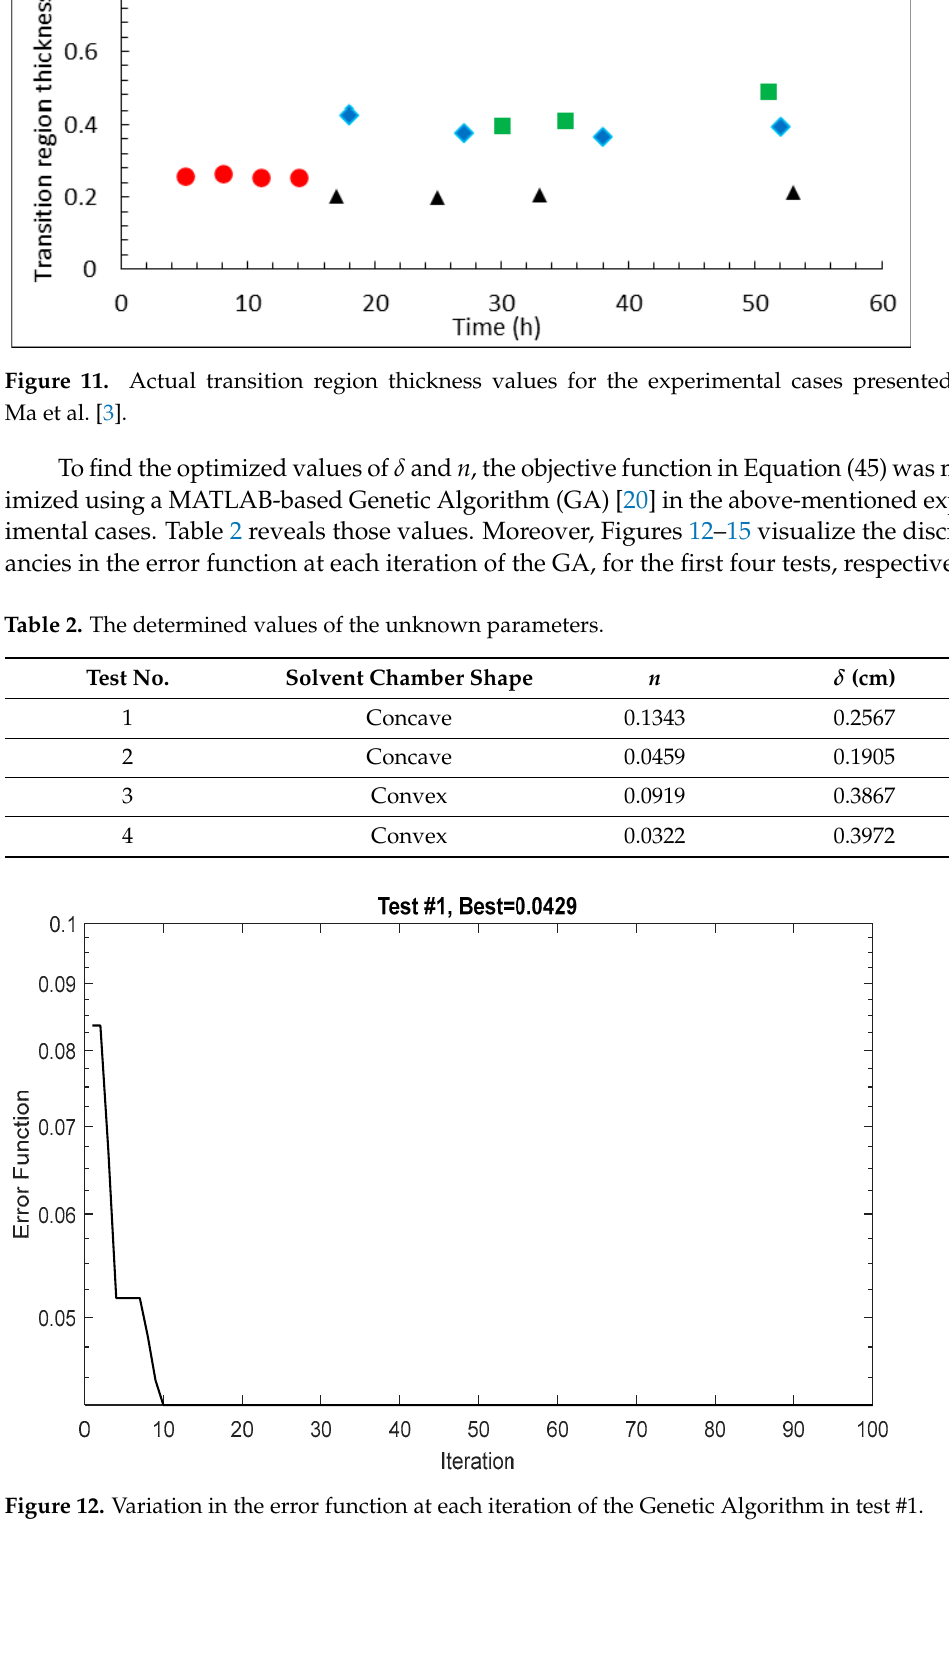
Table 1. Heavy oil and physical model properties for the experimental cases presented by Ma et al. [3].